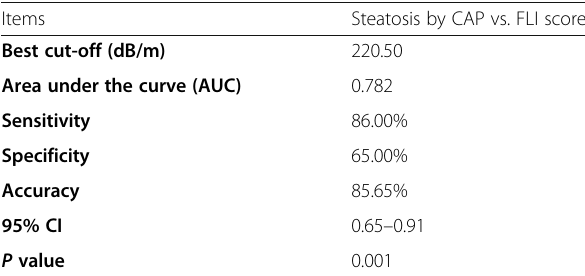
Table 5 Sensitivity, specificity, and accuracy for steatosis by CAP and non-invasive assessment scores